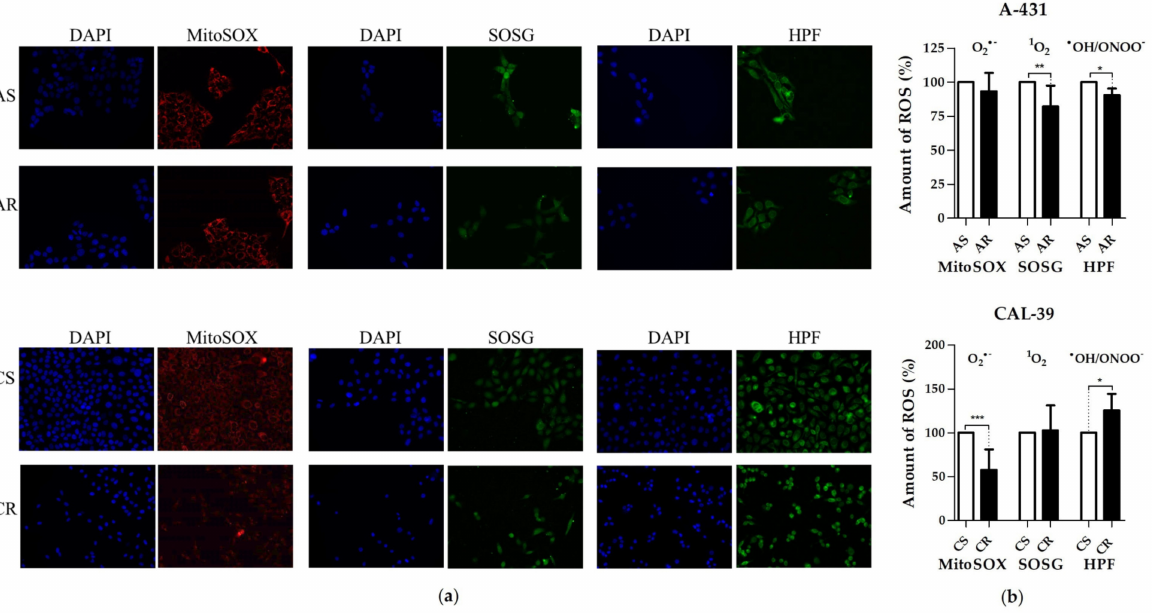
Figure 6. Analysis of ROS type. ( a ) Images of stained cells with Hoechst and MitoSOX, Singlet Oxygen Sensor Green (SOSG) or hydroxyphenyl fluorescein (HPF). Pictures were taken by the use of Olympus ScanR fluorescence microscope with 20 × objective. ( b ) Graph with percentage values of mean fluorescence of untreated parental cells. Asterisks indicate the statistical significance of differences between sensitive and resistant cells calculated via Mann-Whitney test (* p ≤ 0.05, ** p ≤ 0.01, *** p ≤